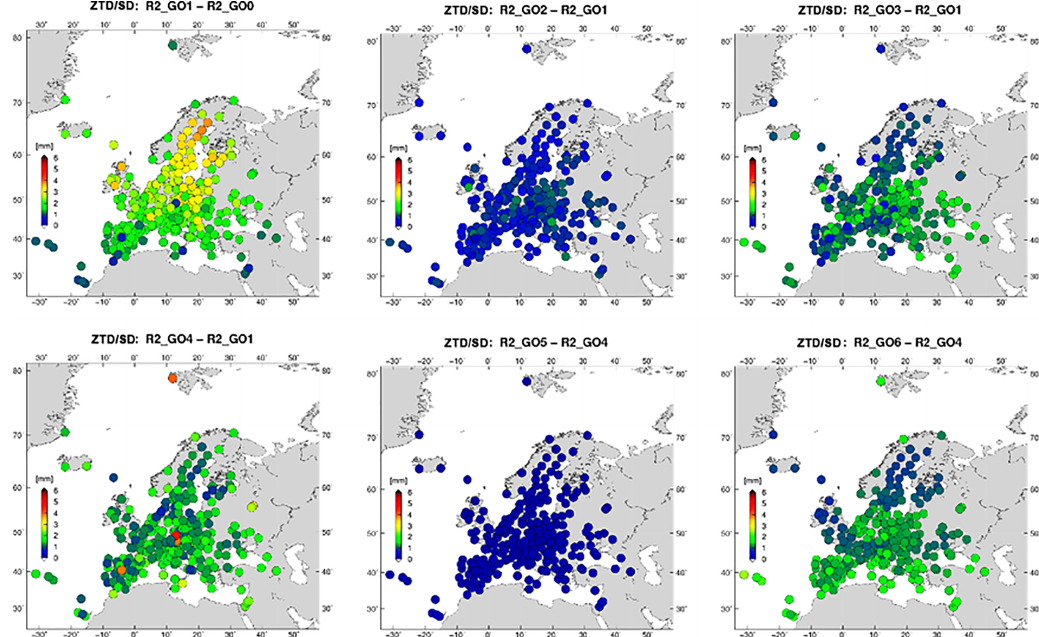
Figure 11. Geographic visualization of standard deviations from inter-comparisons of the GOP second reprocessing